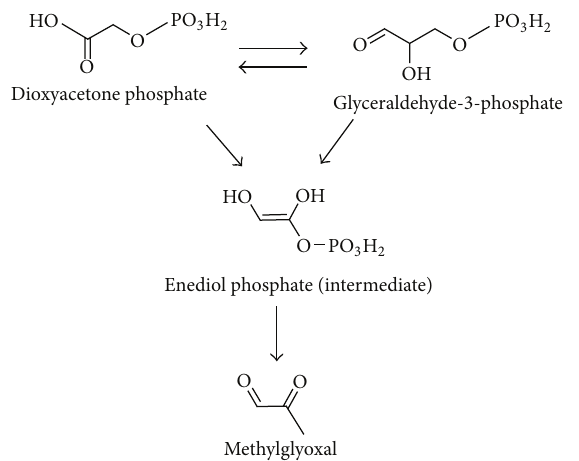
Figure 3: Polyol pathway as a source of formation of reactive carbonyl